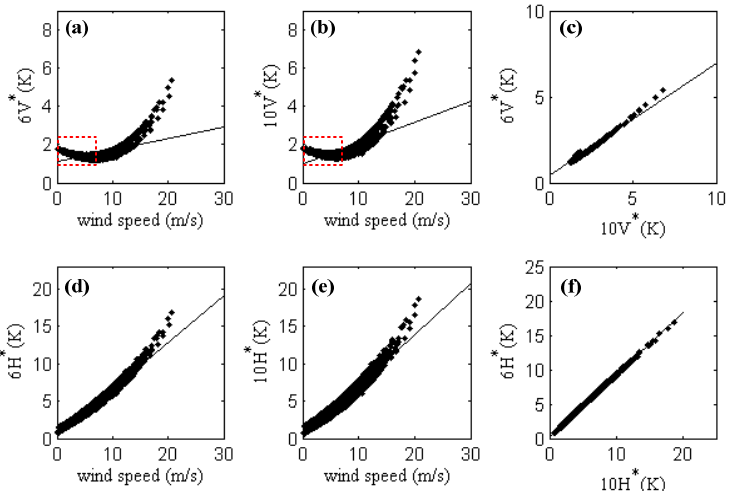
Figure 4. ( a ) Relationship between 6V* and ECMWF wind speed; ( b ) Relationship between 10V* and ECMWF wind speed; ( c ) Relationship between 6V* and 10V*; ( d ) Relationship between 6H* and ECMWF wind speed; ( e ) Relationship between 10H* and ECMWF wind speed; ( f ) Relationship between 6H* and 10H*.